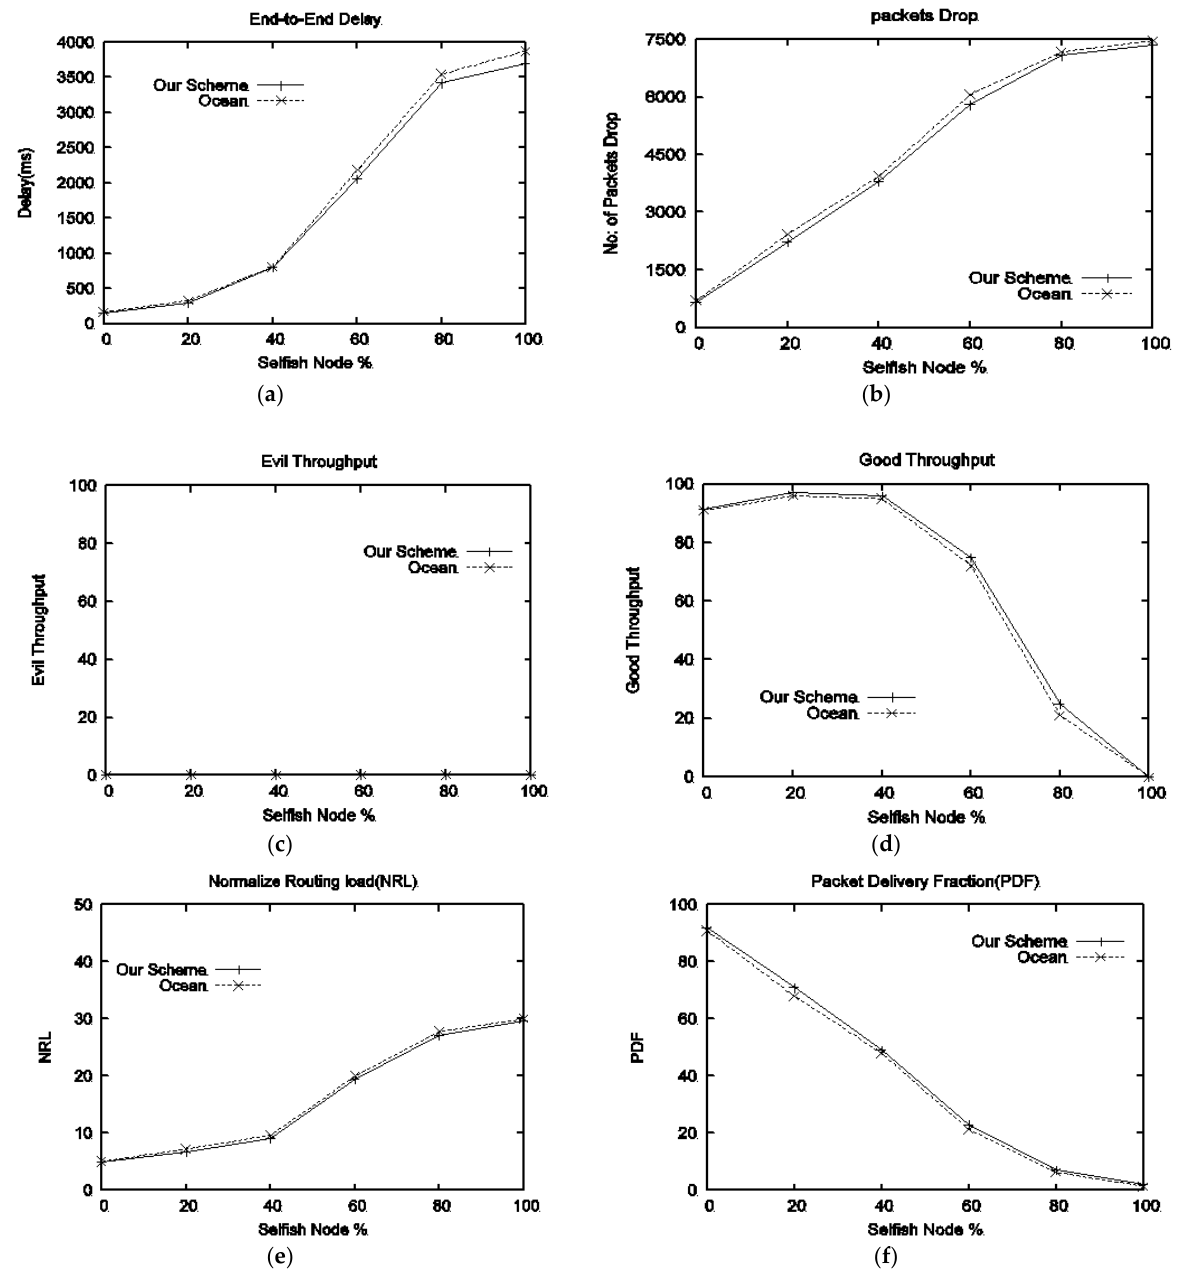
Figure 7. Performance comparison with respect to varying selfish nodes percentage: ( a ) delay vs. selfish nodes, ( b ) average drop packets vs. selfish nodes, ( c ) evil throughput vs. selfish nodes, ( d ) good throughput vs. selfish nodes, ( e ) NRL vs. selfish nodes, ( f ) PDF vs. selfish nodes.